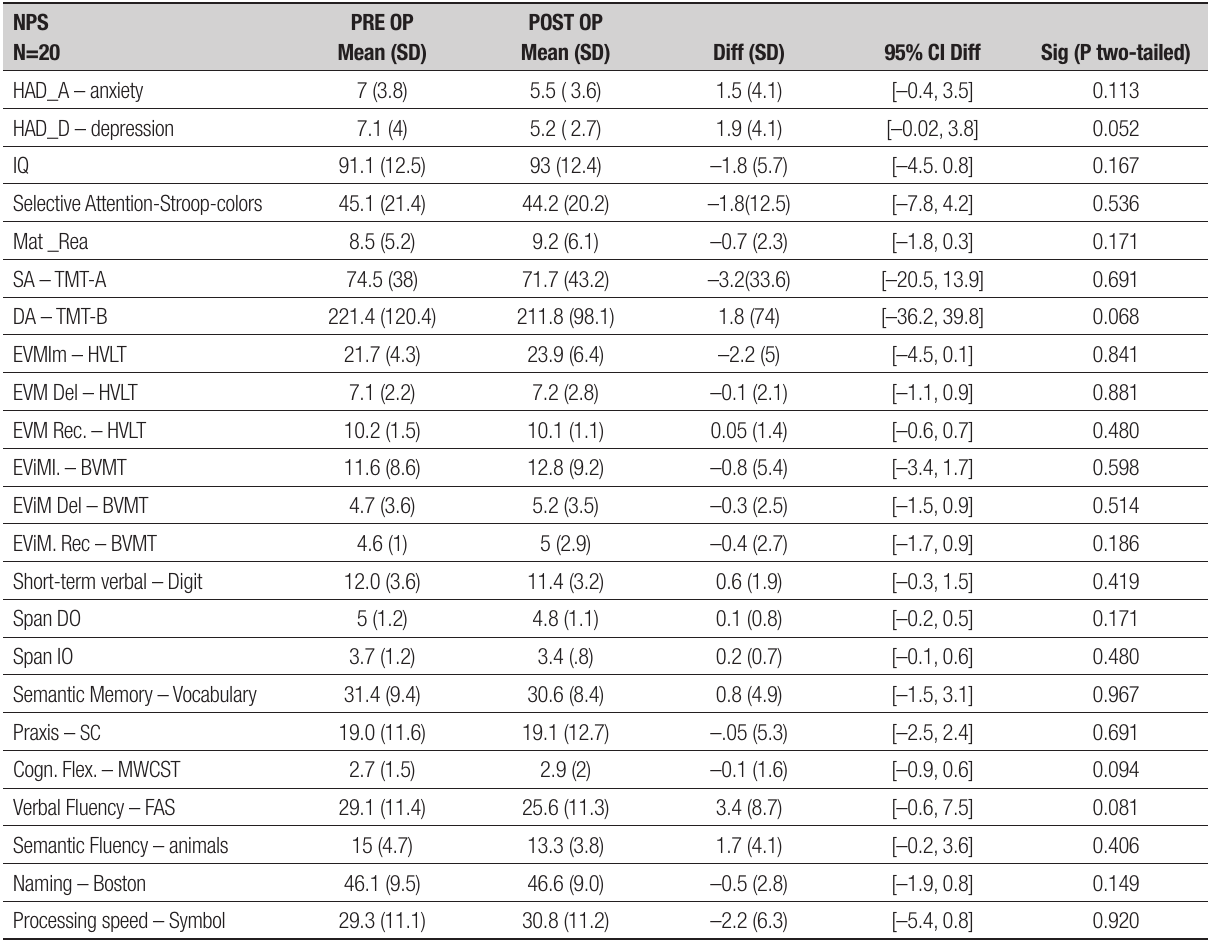
Table 2. Comparison of pre and post-operative battery.